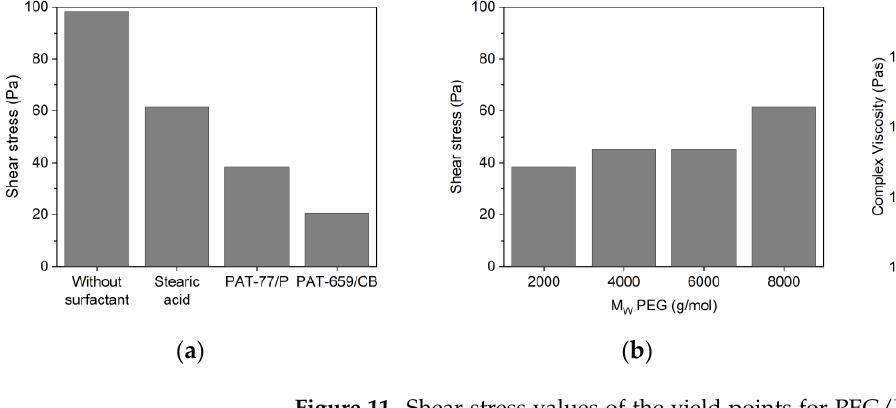
Figure 11. Shear stress values of the yield points for PEG/PMMA feedstocks (160 °C, solid load 60 vol%). ( a ) Applying PEG 8000 and different surfactants; ( b ) applying PEGs with different M W and SA as surfactant; ( c ) complex viscosity as function of temperature and PEG with different M W and SA as surfactant.